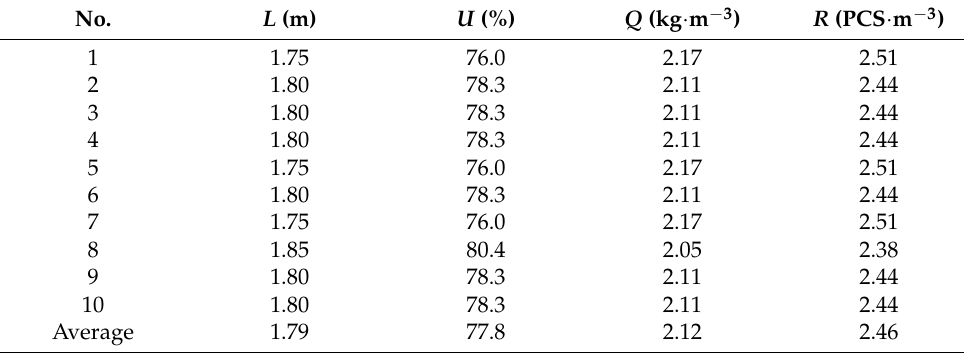
Figure 11. Blasting hole layout of the optimized scheme (unit: mm).